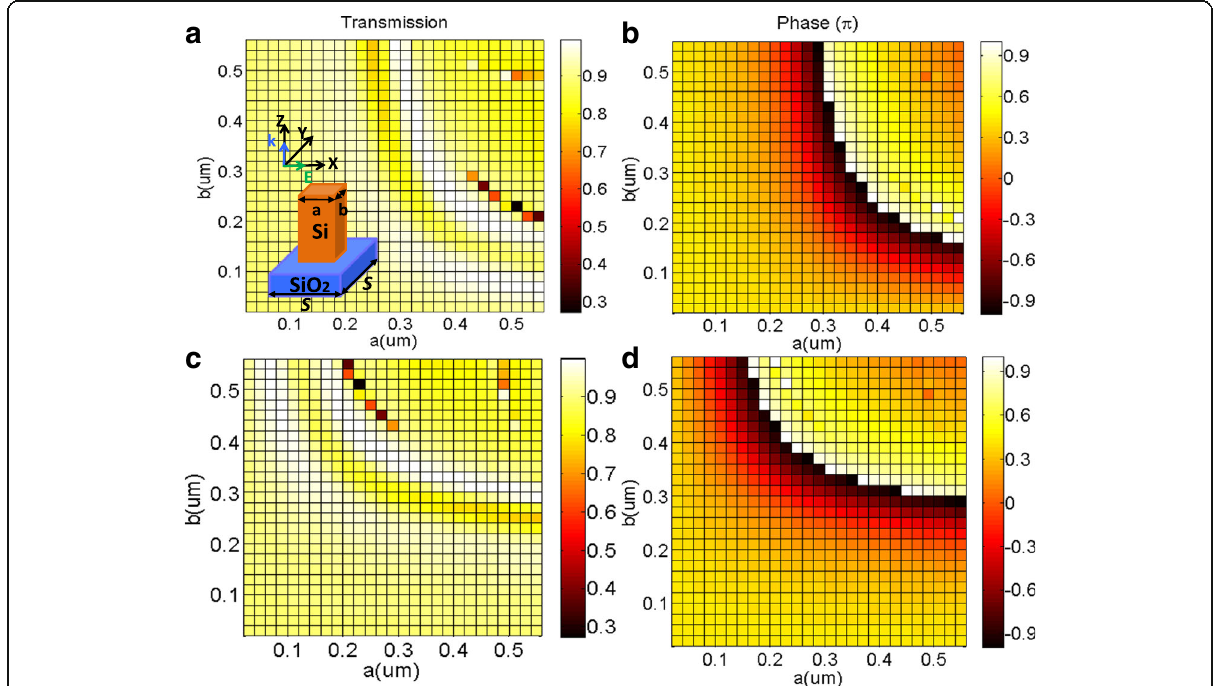
Fig. 1 a The transmission efficiency and b the corresponding phase variations of XLP light as a function of parameters a and b . c The co-polarized transmission efficiency and d corresponding phase variations of YLP light as a function of parameters a and b . The inset in a schematically shows the unit cell of periodic dielectric metasurface consisting of an array of silicon nanobricks on top of SiO 2 substrate. The thickness of silicon nanobricks and SiO 2 substrate is set as 900 nm and 200 nm,